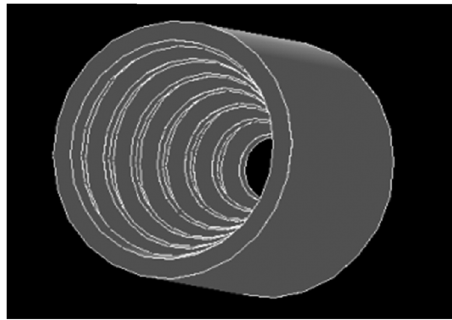
Figure 3: Anti - scattering